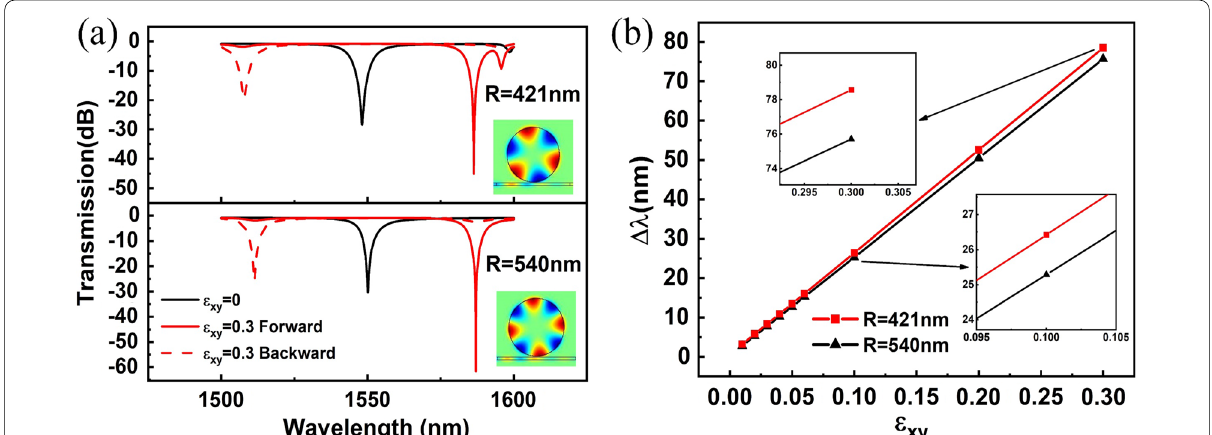
Fig. 5 The transmission spectra and wavelength splitting of the disc cavity with different radii. a The transmission spectra of light from different propagation directions are coupled into a disc cavity with different radii. The insets correspond to the intensity distribution of the z component of the magnetic field when ε xy = 0 . b Linear graph of wavelength splitting for disc cavity with different